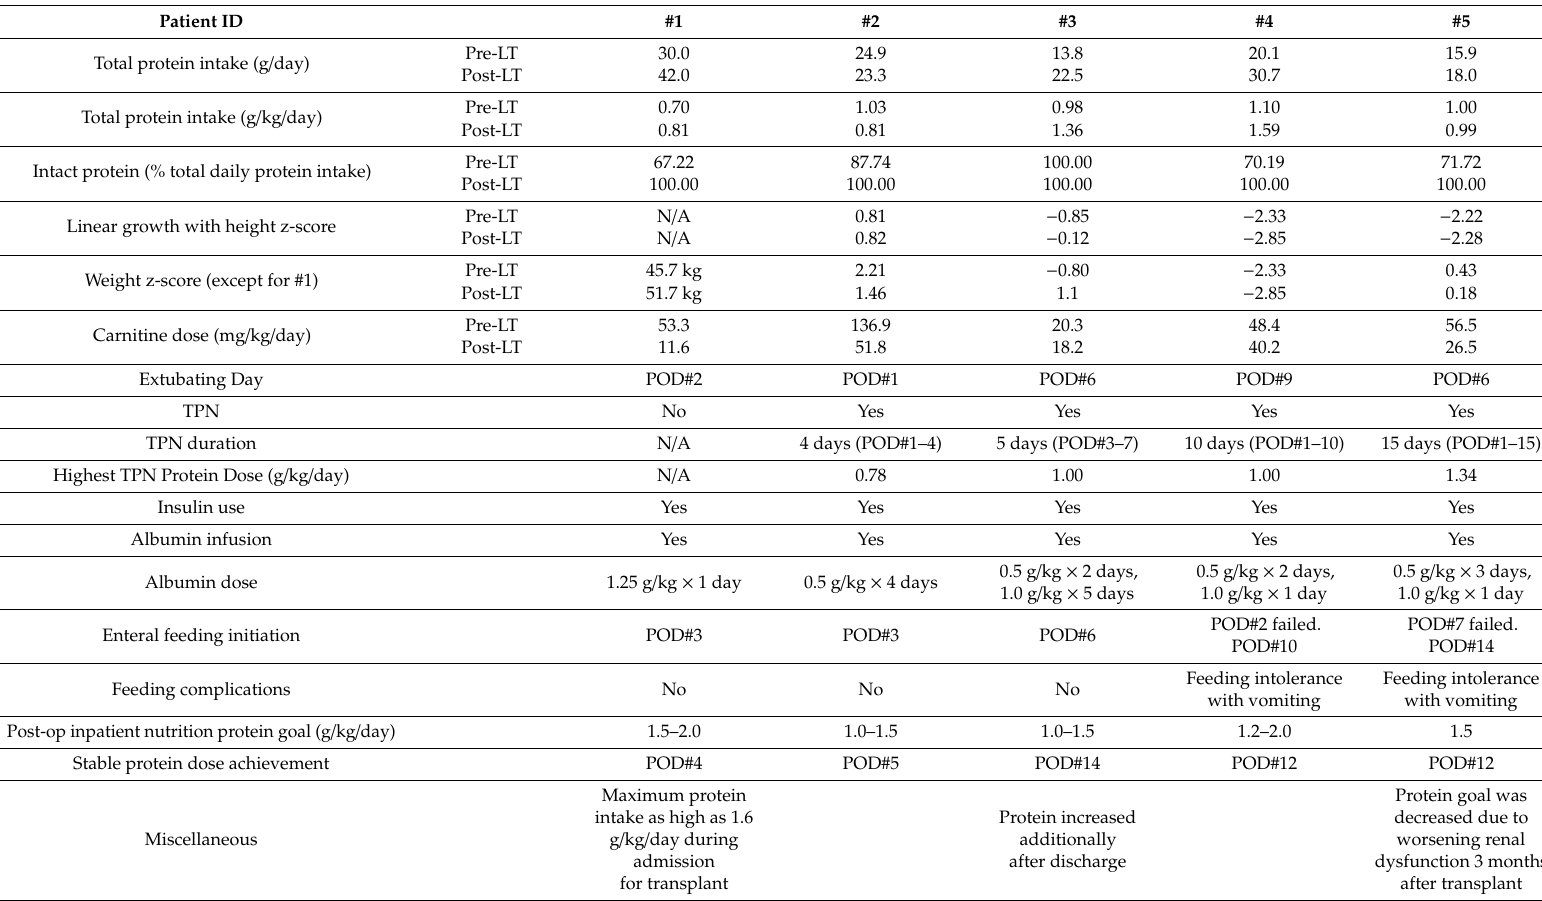
Table 3. Post-operative nutritional interventions and outcome for the six months duration before and after liver transplant. Patient ID